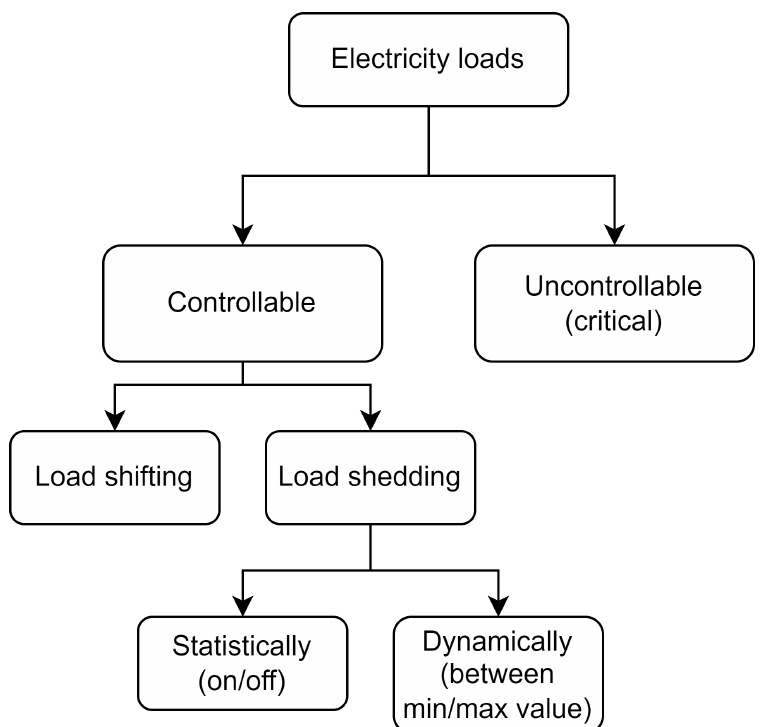
Figure 5. Overview and division of electricity